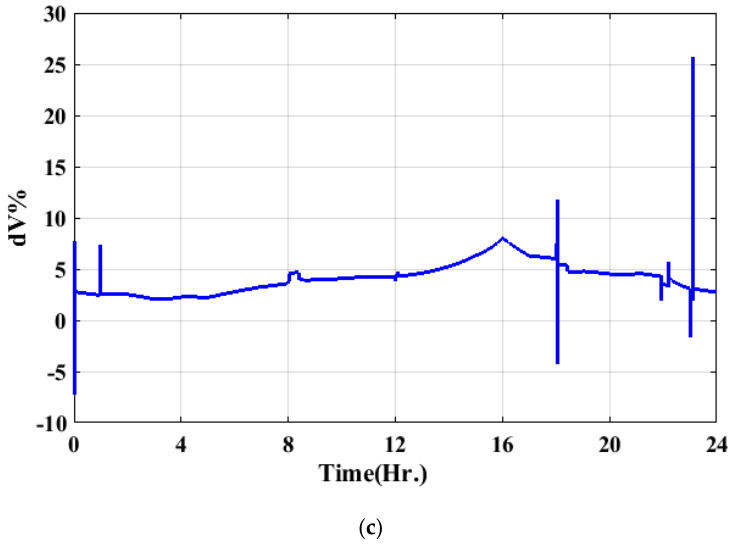
Figure 14. Load Voltage deviation; ( a ) without any compensations, ( b ) with V2G compensations, ( c ) and with DSTATCOM and V2G compensations.